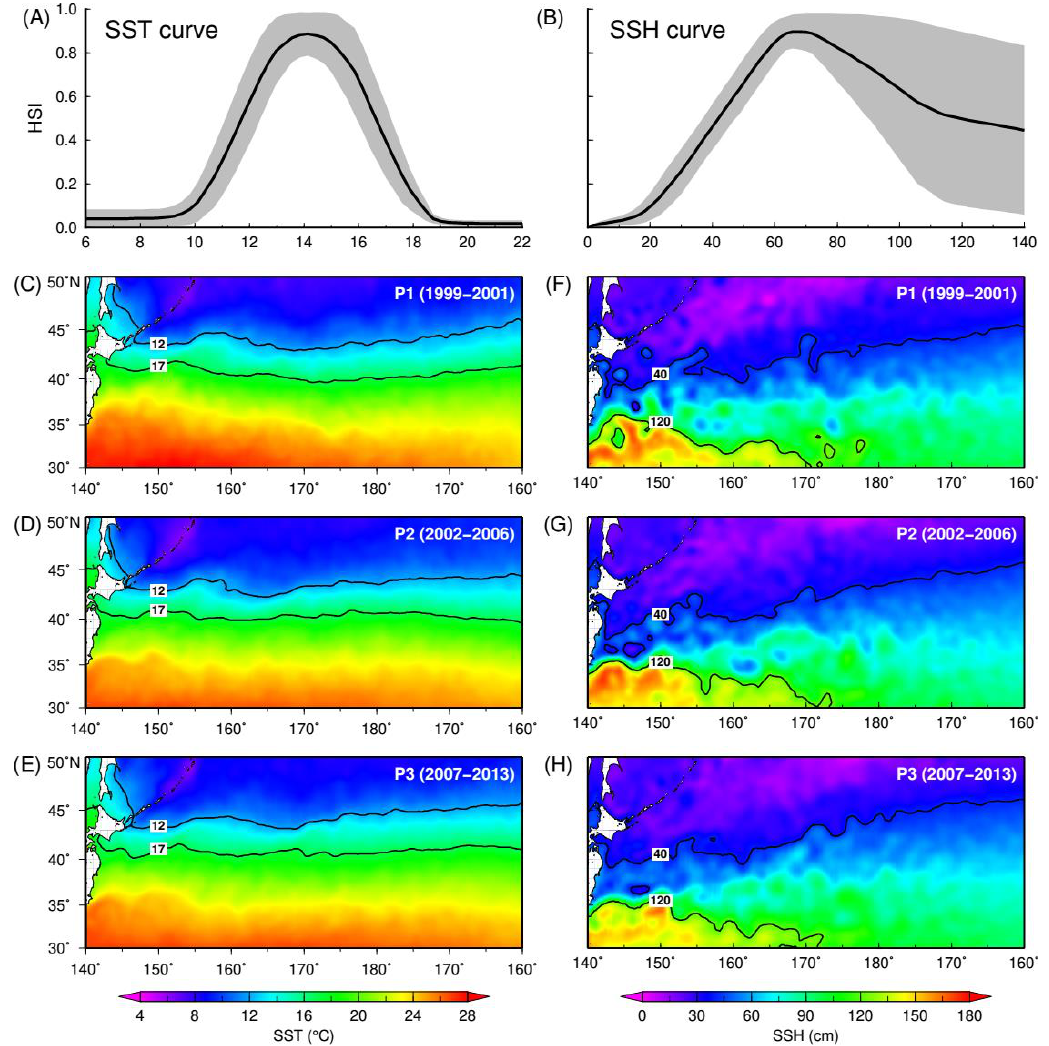
Figure 4. Multi-model squid habitat response curves for the ( A ) SST and ( B ) SSH, averaged from eight (8) single-algorithm models with the corresponding ±1 standard deviation (SD; gray shading). Spatial distributions of the summer-averaged (May–July) SST and SSH for the following periods, respectively: ( C , F ) P1 (1999–2001), ( D , G ) P2 (2002–2006), and ( E , H ) P3 (2007–2013). Overlain as solid lines are the model-derived optimal ranges for SST (12–17 °C) and SSH (40–120 cm) at each period.